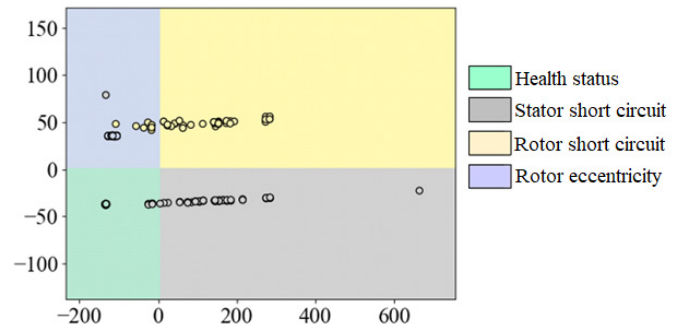
Figure 5. Classification result without the fuzzy process.